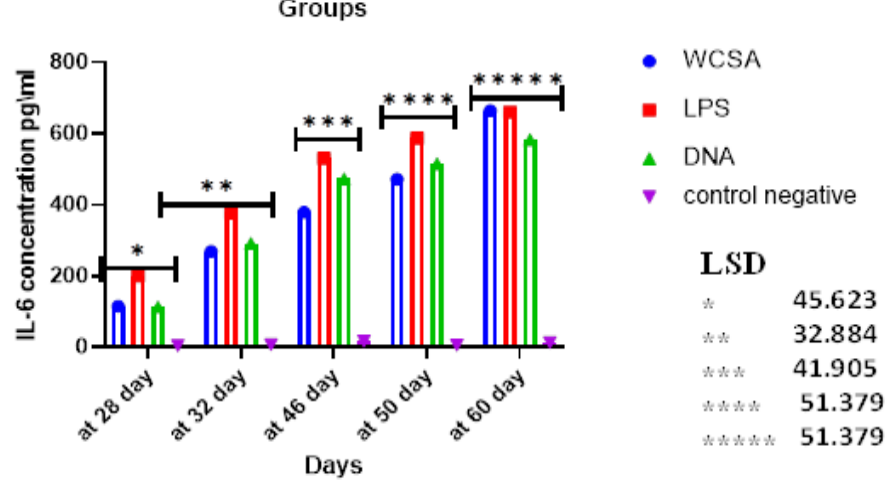
Figure 1. IL-6 concentration in the immunized groups with different antigens